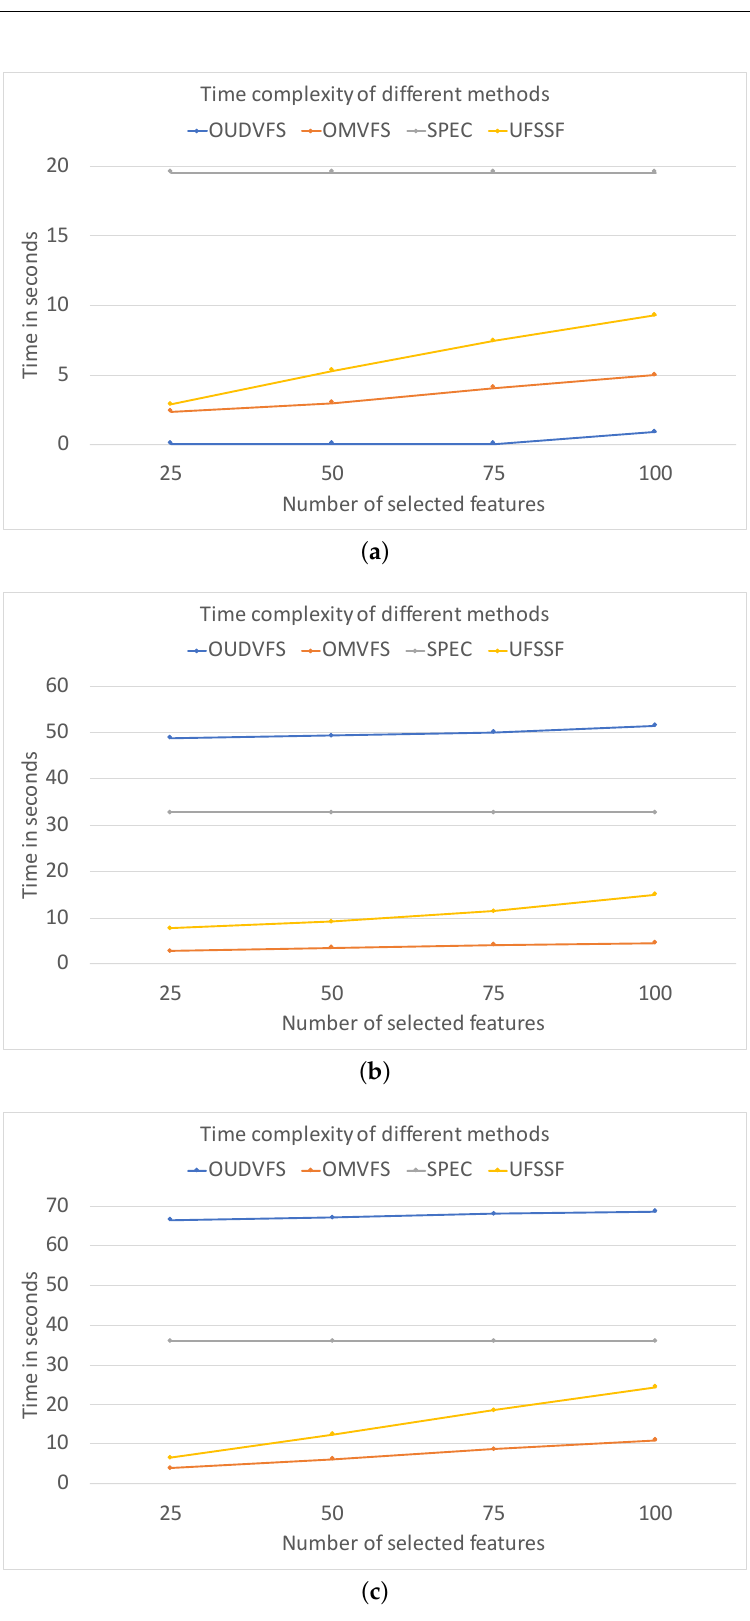
Figure 5. Time complexity of different methods on ( a ) Handwritten dataset, ( b ) Caltech-7 dataset, and ( c ) Fox News